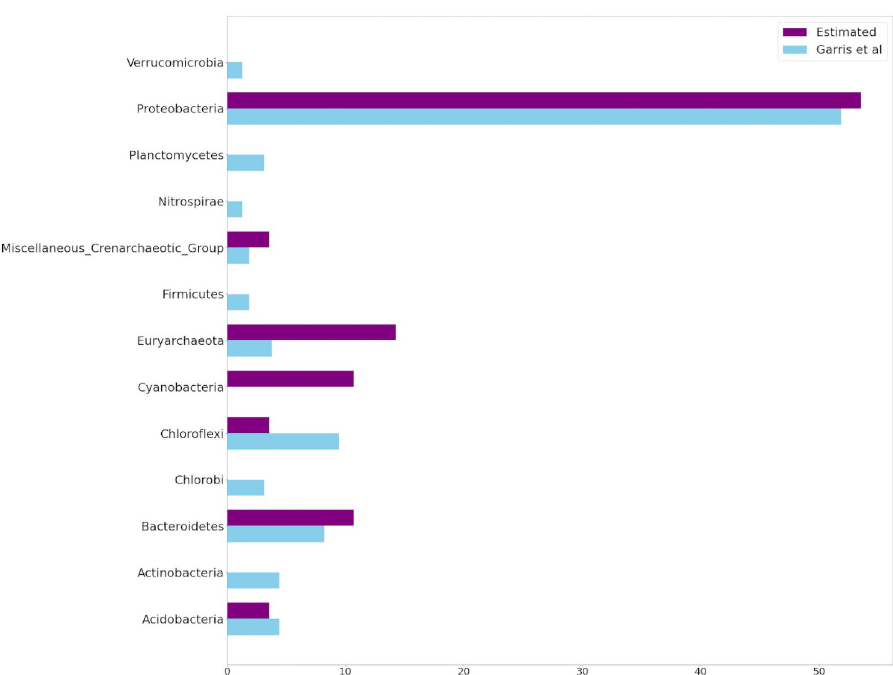
Fig 18. Taxonomic comparison of indicator species at the phylum level. Blue bars represent the indicators identified by Garris et al [34]. Purple bars represent the indicators identified by our proposed feature extractor. The horizontal axis represents the percentage of indicators belonging to each